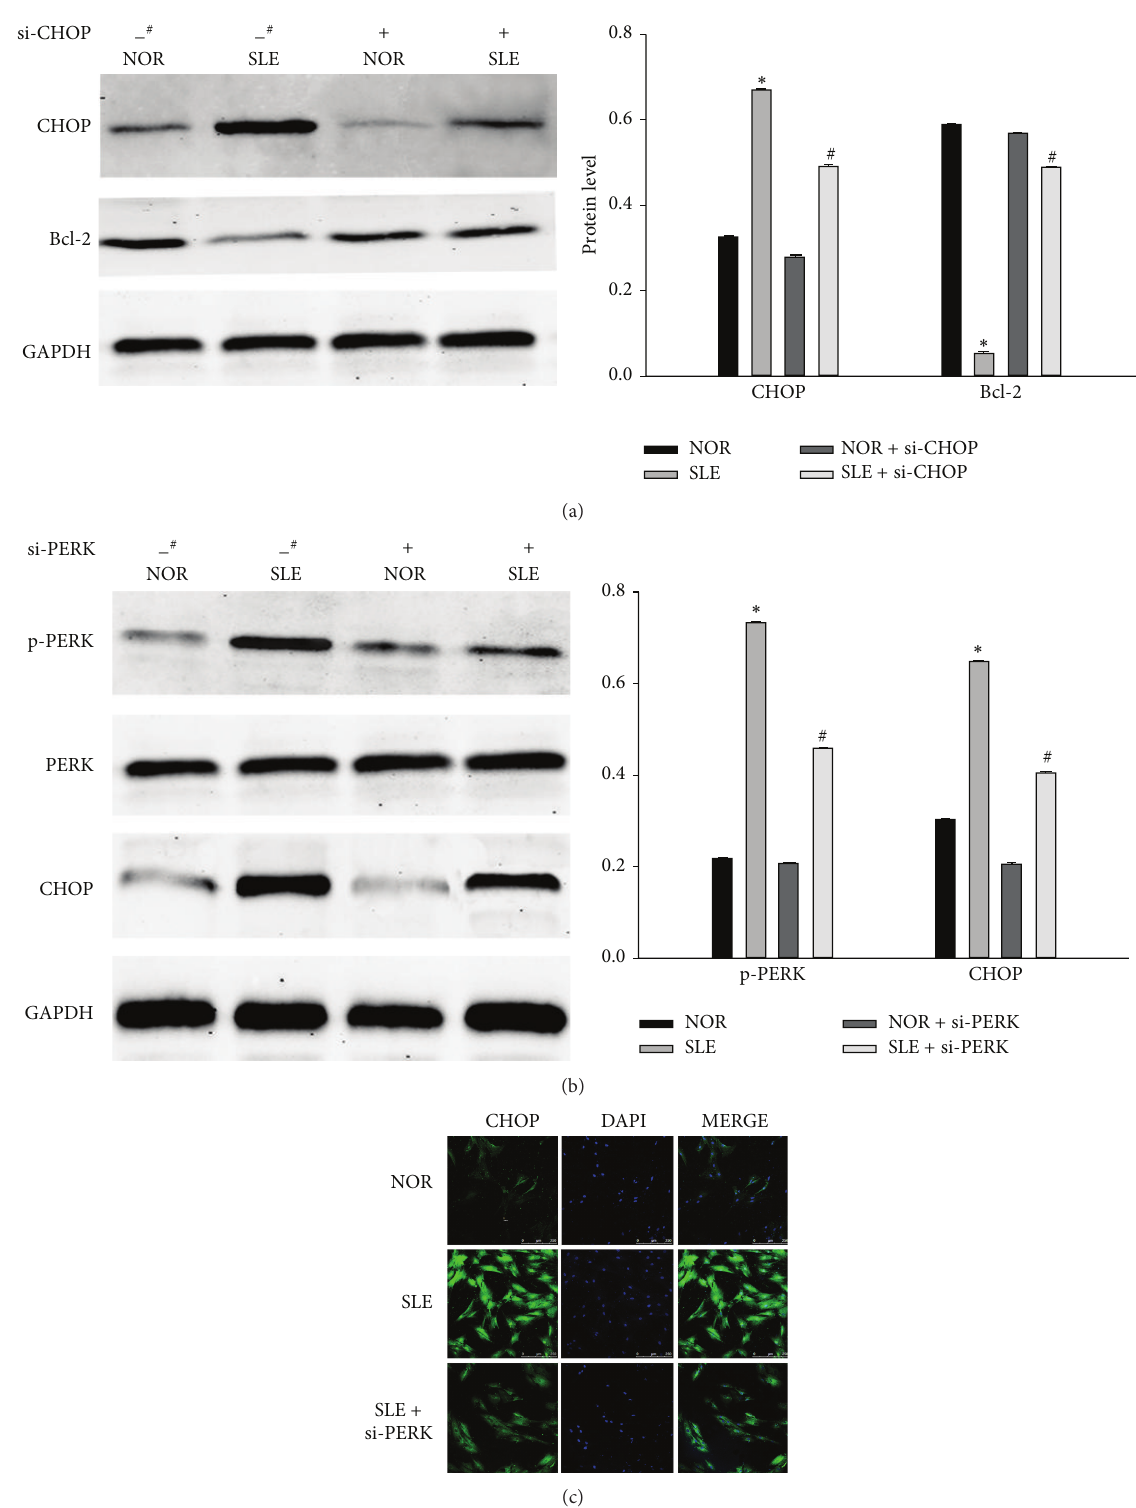
Figure 4: The role of ERS in apoptosis of BM-MSCs from SLE patients. (a) BM-MSCs of SLE patients and normal controls were transfected with scramble siRNA ( # ) and 40nM CHOP siRNA respectively, for 48h using the RNAifect transfection reagent. Western blot analysis was performed for CHOP and Bcl-2 respectively. (Bar represents mean ± SD, ∗ 𝑃 < 0.05 compared with the normal group, # 𝑃 < 0.05 compared with the SLE group). (b) BM-MSCs of SLE patients and normal controls were transfected with scramble siRNA ( # ) and 50 nM PERK siRNA, respectively, for 48 h using the RNAifect transfection reagent. Western blot analysis was used for PERK and CHOP respectively. GAPDH was used as an internal control. (Bar represents mean ± SD, ∗ 𝑃 < 0.05 compared with the normal group, # 𝑃 < 0.05 compared with the SLE group). (c) Immunofluorescence analysis was performed for CHOP